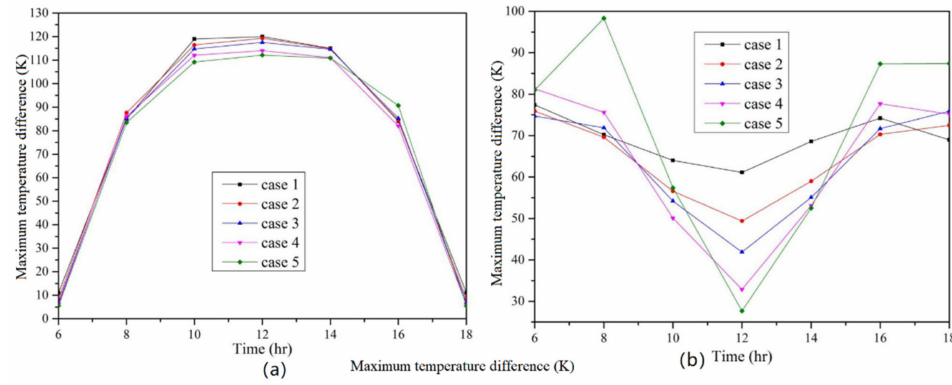
Figure 10. Maximum temperature differences of solar array. ( a ) On the winter solstice; ( b ) on the summer